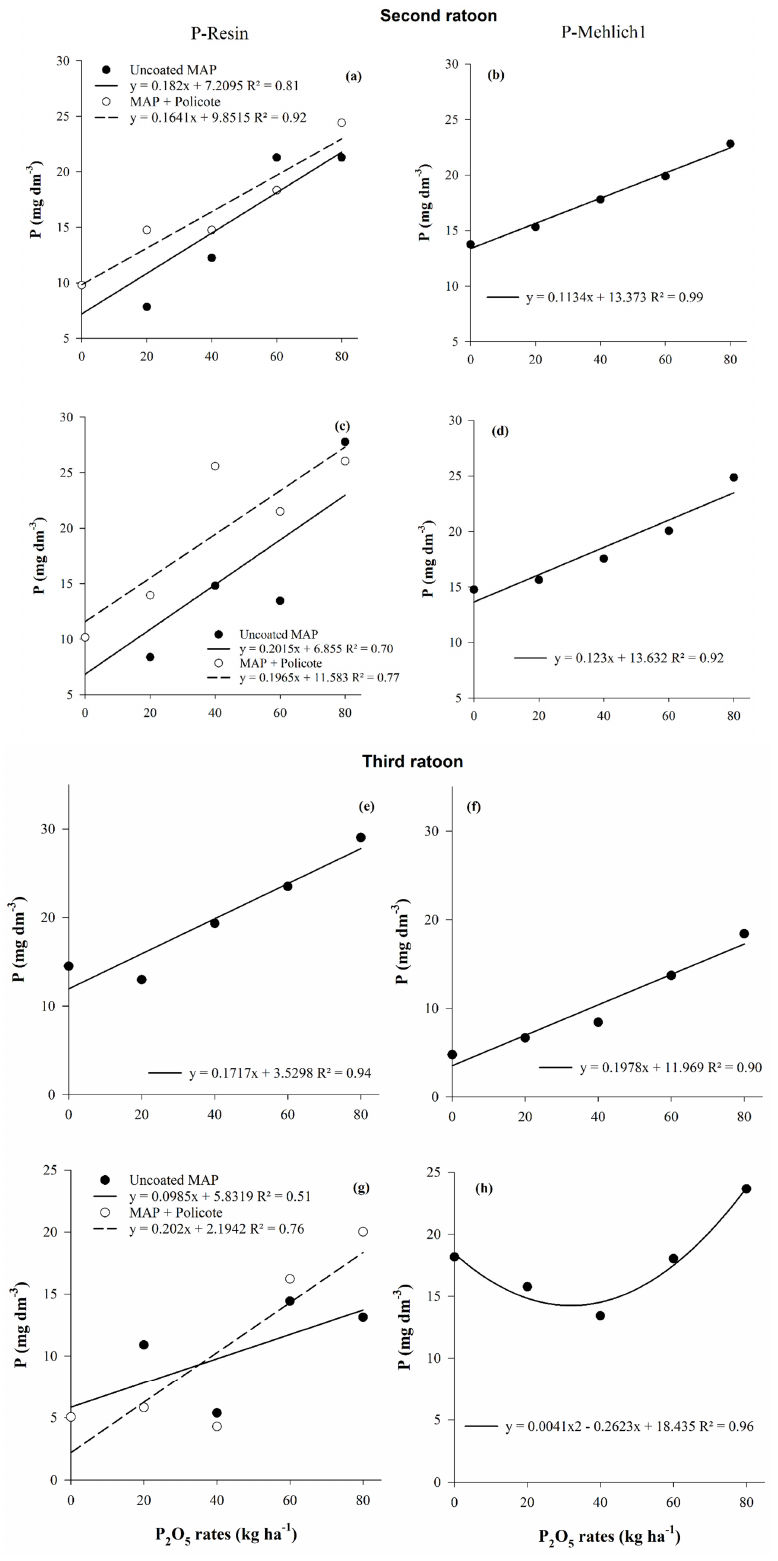
Figure 3. Phosphorus content in soil in response to fertilization with different phosphorus rates with and without Policote coating, extracted by P-Resin from the layer 0–0.10 m ( a , e ) and 0.10–0.20 m ( c , g ), and by Mehlich-1 from the layer 0–0.10 m ( b , f ) and 0.10–0.20 m ( d , h ). Growing seasons 2018/2019 and 2019/2020.